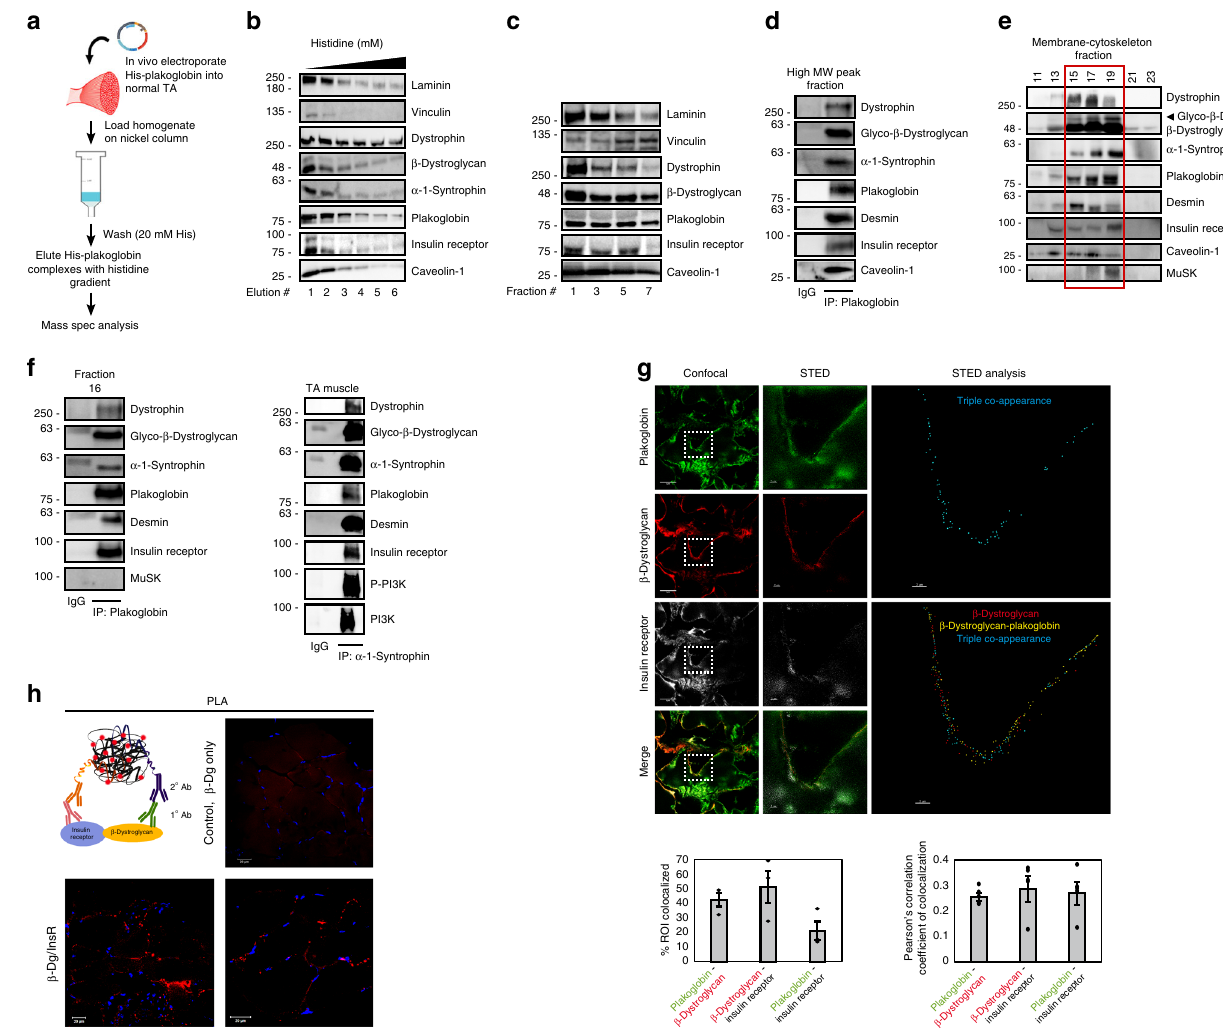
Fig. 2 Plakoglobin binds DGC components and insulin receptors at costameres on the plasma membrane. a Af fi nity-based puri fi cation of plakoglobin- containing complex. 6His-tagged plakoglobin encoding plasmid was electroporated into muscle, and 6His-plakoglobin-bound proteins were isolated with Nickel beads and identi fi ed by mass spectrometry. b 6His-plakoglobin-bound proteins were eluted from Nickel column with histidine gradient (50 – 250 mM) and analyzed by immunoblotting. Fraction #2 was subjected to mass spectrometry. n = one experiment, data were compared to Fig. 1g, h. c Analysis of high MW protein fractions (as in Fig. 1c) by immunoblotting. n = two independent experiments. d Plakoglobin immunoprecipitation from the high MW protein peak. Bound proteins were detected by immunoblotting. e Plakoglobin, DGC components (including glycosylated- β -dystroglycan), the insulin receptor, caveolin-1, desmin, and MuSK sediment to the same glycerol gradient fractions (marked by a red rectangle). Membrane-cytoskeleton fraction from mouse muscle was analyzed by 10 – 40% glycerol gradient and immunoblotting. n = two independent experiments. f In normal muscle, plakoglobin, DGC components, the insulin receptor, and desmin interact. Left: Proteins co-puri fi ed with anti-plakoglobin from fraction #16 in e , and detected by immunoblotting. MuSK did not bind plakoglobin, although it sedimented to the same fractions. Right: Reciprocal immunoprecipitation with α -1-syntrophin antibody from membrane fractions isolated from normal muscle. Two experiments were performed: One with plakoglobin antibody and one with α -1- syntrophin antibody. g Plakoglobin, β -dystroglycan, and the insulin receptor potentially colocalize at costameres on the skeletal muscle membrane. STED: Stimulated emission depletion microscopy. Confocal (bar, 5 μ m) and STED (bar, 2 μ m) images of muscle cross-sections stained with the indicated antibodies. n = three independent experiments. STED analysis was performed using the spots module of the Imaris software for the three proteins. The double and triple co-occurrence spots are presented in yellow (plakoglobin- β -dystroglycan) and blue (plakoglobin- β -dystroglycan-insulin receptor). Right: Percent colocalization of indicated proteins in region of interest (the region of co-occurrence, confocal images), and the corresponding Pearson ’ s correlation coef fi cients of colocalization. n = 3, and two independent experiments. Data are represented as mean ± SEM. h Proximity ligation assay (PLA) was performed on TA cross-sections with β -dystroglycan and insulin receptor antibodies or β -dystroglycan antibody alone. Red fl uorescent dots indicate areas of β -dystroglycan-insulin receptor